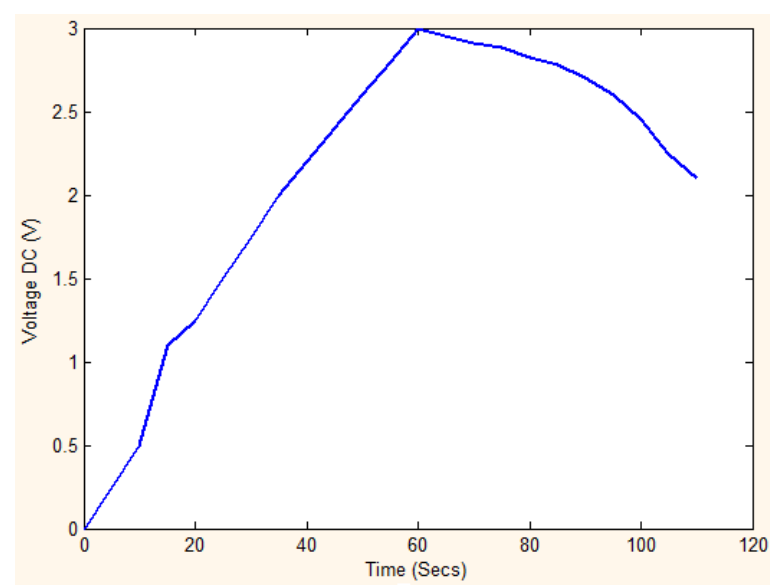
Figure 11. Output voltage of the TEG module over time, when heated with the palm of the hand.